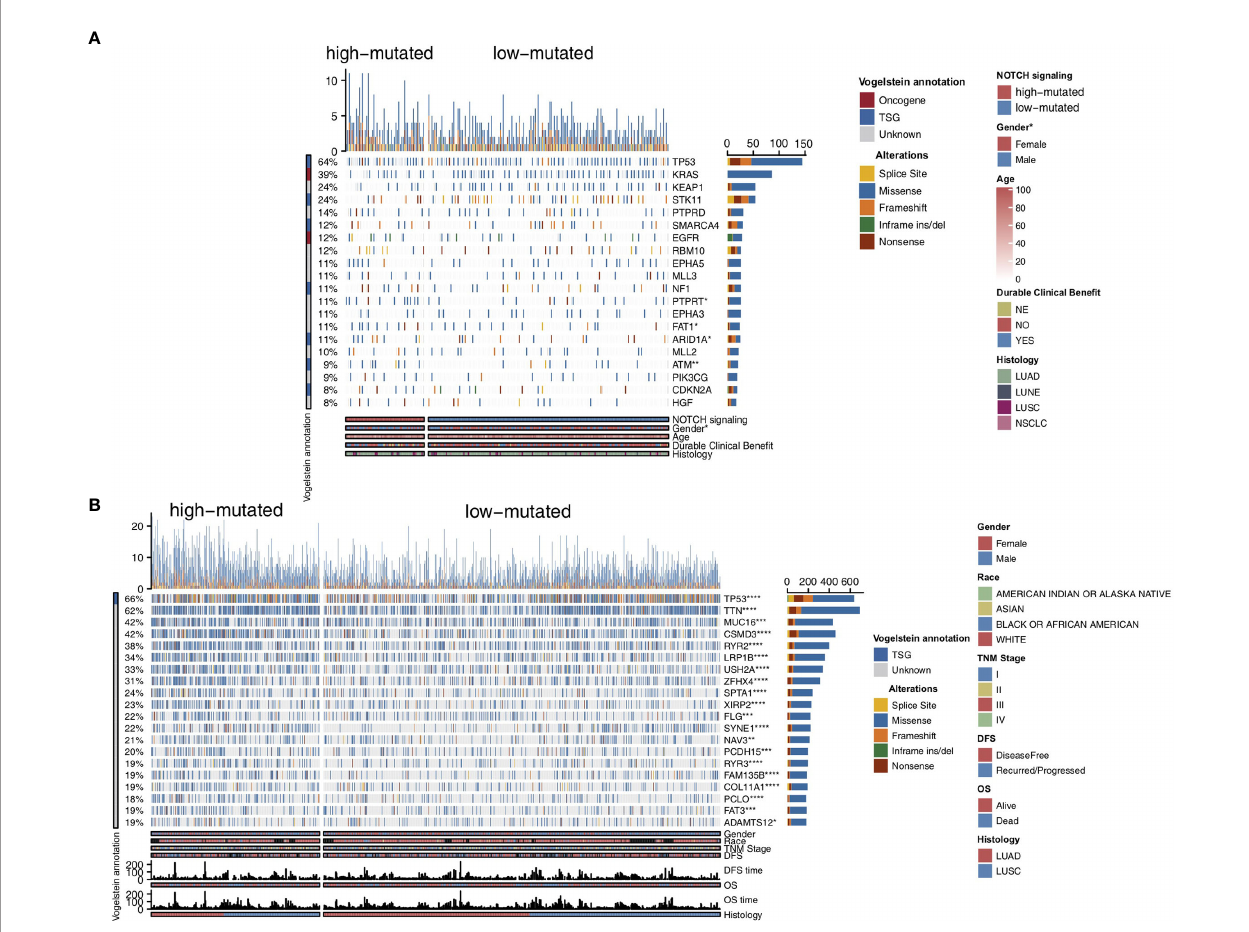
FIGURE 2 | Genomic pro fi les of the NSCLC patients in the MSKCC (A) and TCGA (B) cohorts. The top 20 genes with the highest mutation frequencies and the corresponding clinical information are shown in the fi gure. The top fi ve genes with the highest mutation frequencies in the MSKCC cohort were TP53, KRAS, KEAP1, STK11 and PTPRD. The top fi ve genes with the highest mutation frequencies in the TCGA cohort were TP53, TTN, MUC16, CSMD3 and RYR2. The mutation types are indicated as follows: yellow indicates splice sites, blue indicates missense mutations, orange indicates frameshift mutations, green indicates inframe insertions/deletions, and brown indicates nonsense mutations. The clinical characteristics are shown as patient annotations. (*P < 0.05; **P < 0.01; ***P < 0.001; ****P < 0.0001; Mann-Whitney U